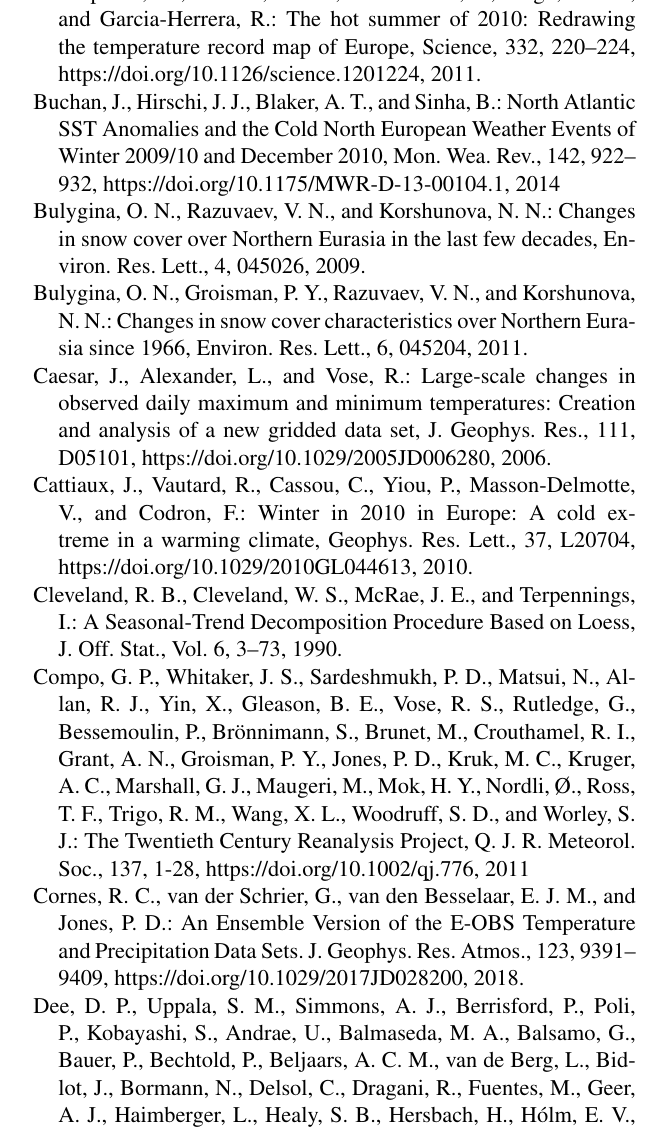
Code and data availability.